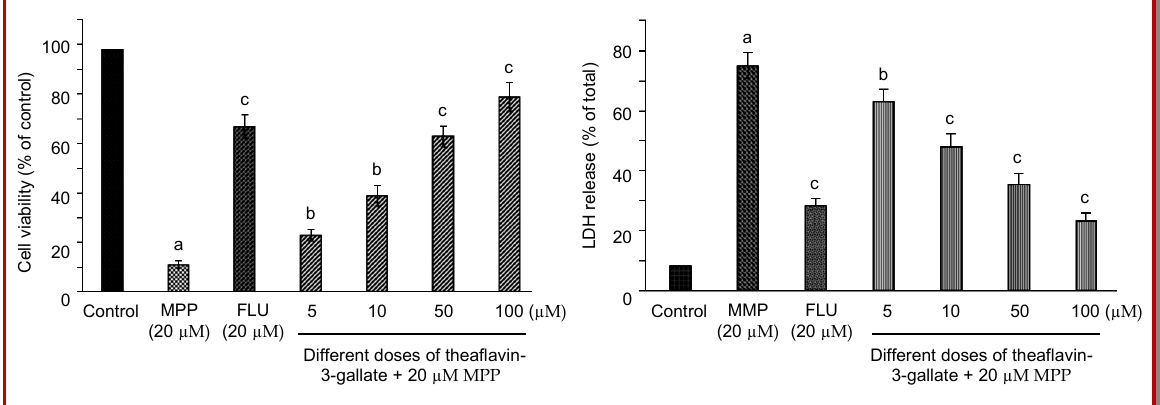
Figure 1: Effect of theaflavin-3-gallate on cell viability and LDH leakage in 1-methyl-4-phenyl pyridinium (MPP)-treated N2a cells. Values given are the mean ± S.E.M. (n = 6). a p<0.01 as compared with control group; b p<0.05, c p<0.01 as compared with 1-methyl-4 -phenyl pyridinium group; Contr means control; FLU means